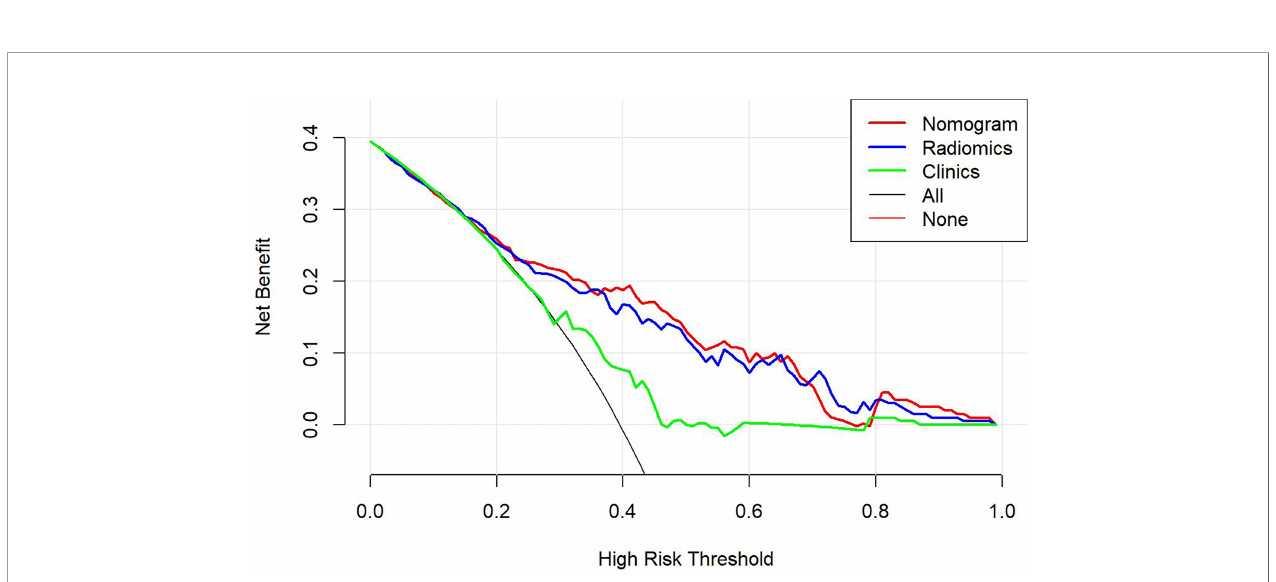
FIGURE 11 | The decision-making curves of the radiomics, clinical radiomics, and clinical models based on the T1-weighted imaging (T1WI) sequence, where the X- and Y-axes represent the threshold probability and net bene fi t, respectively. Red indicates the clinical radiomics model, blue stands for the radiomics model, and green represents the clinical model. The Y-axis represents the 0-parallel line, indicating that all samples were negative (assuming that all patients were in the non- response group after treatment). The black line is based on the assumption that all samples were positive (in the response group after treatment), and the net bene fi t is represented by the diagonal line with a negative slope. The net bene fi t is the proportion calculated by subtracting the false positive count from the true positive count. The threshold probability (Pt) was within the range of 0.2 – 0.8. The clinical radiomics nomogram had a higher Pt and corresponding net bene fi ts than the clinical model, indicating that it attained a higher clinical net bene fi t in predicting the therapeutic effect of neoadjuvant chemotherapy.